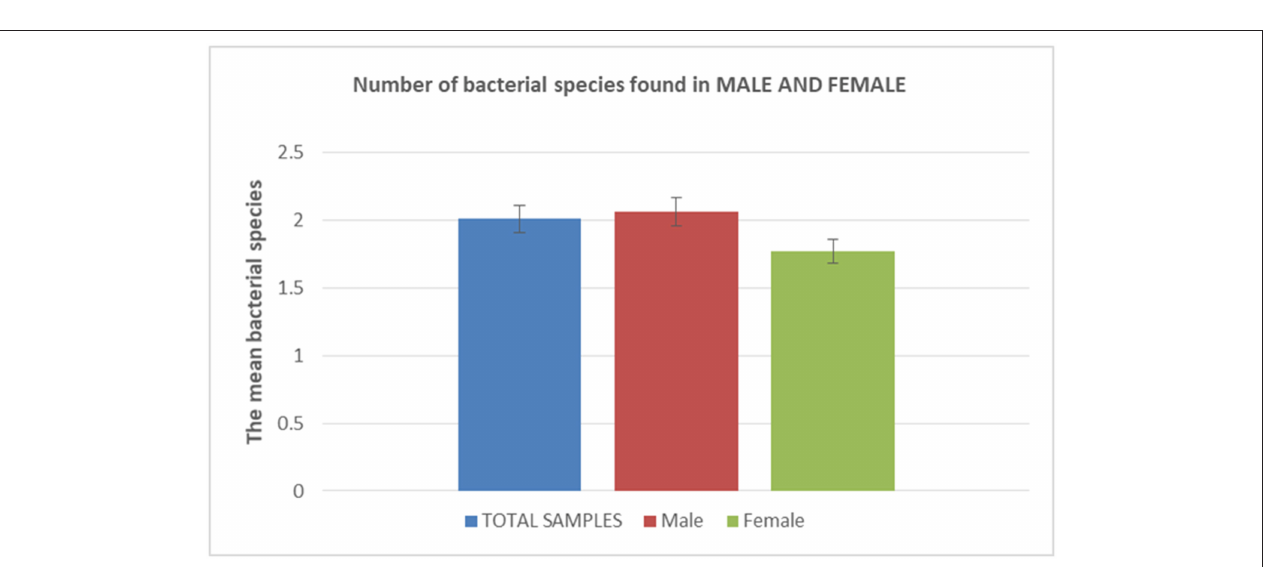
FIGURE 2 | Number of bacterial species found in males and females. The histogram is showing the mean number of bacterial species accordingly to males/females status. In blue characters: Total number of samples; in red characters: total number of sample in male patients; in green characters: total number of samples in female